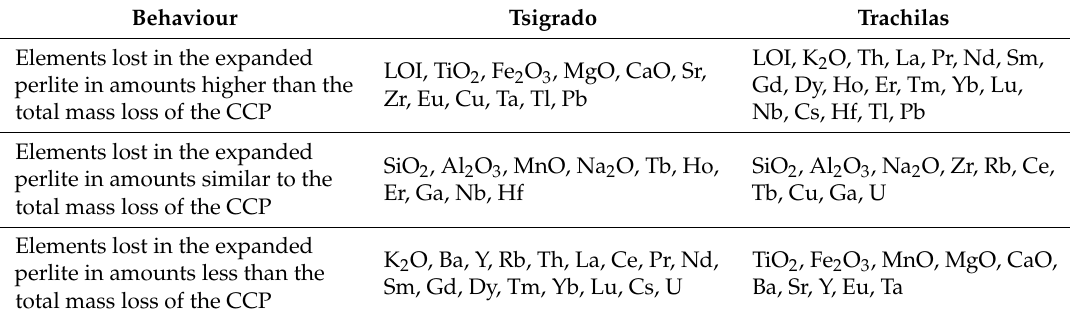
Figure 4. Plot of isocon analysis for crude 1.18–2.5 mm perlite expansion from Tsigrado ( a – d ) and Trachilas ( e ) areas. Insets in diagrams show sample numbers. The abscissa and the ordinate represent original (CCP) and altered (expanded) elemental concentrations, respectively. Isocon lines are drawn on the basis of the calculated mass losses (Table 1). Major elements plotted as weight percent, trace and rare earth elements as ppm. Scaling factors are given in Table S1 (see online Supplementary Materials). Table 3. Categorisation of elements according to their behaviour during expansion of the Tsigardo and Trachilas samples.